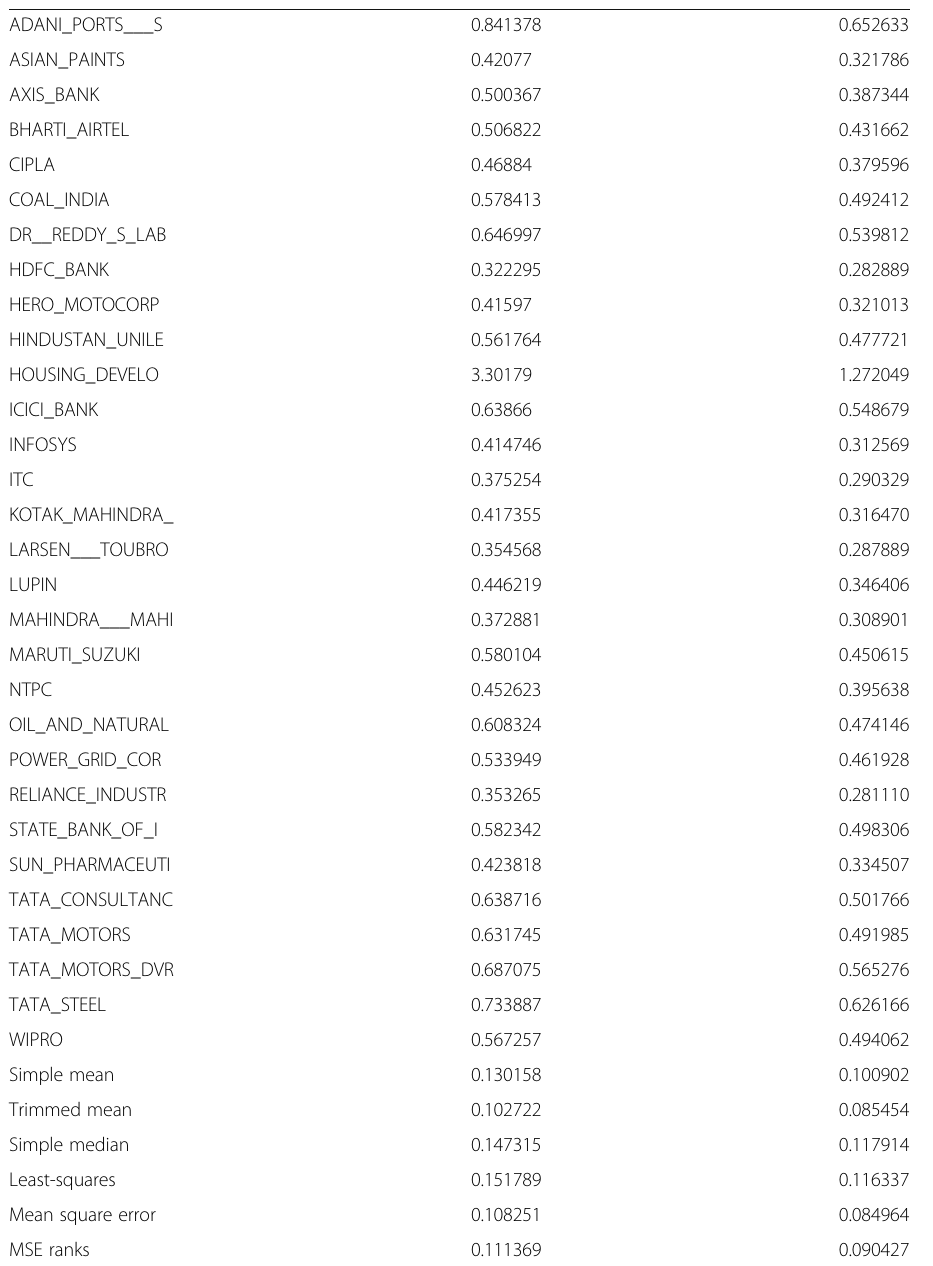
Table 7 Measurements of forecast accuracy